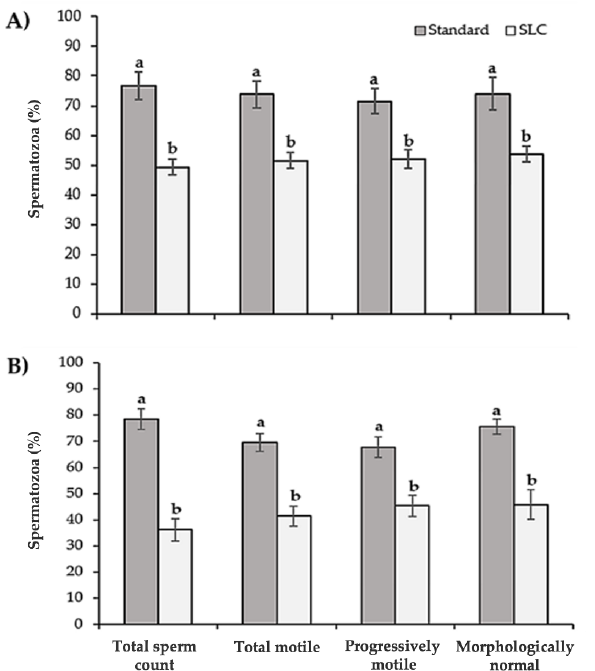
Figure 2. Recovery rates (means ± SEM) after standard centrifugation (in grey) or single layer centrifugation (SLC) (in white) of optimal ( A , normal morphology ≥ 80%) and suboptimal ( B , normal morphology between 60 and 79%) quality ejaculates. a , b Different superscripts indicate significant differences between treatments ( p < 0.05).